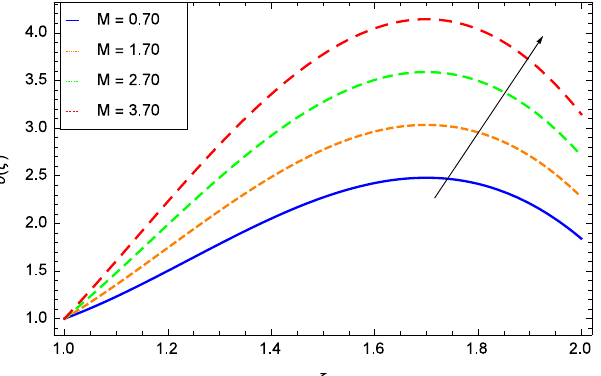
Figure 10. Non-dimensional temperature θ ( ζ ) sketch for h = − 1.10, β 1 = 1.10, φ = 0.04, M = 0.10, Pr = 6.80 and greater quantities of Re (CuO-H 2 O).